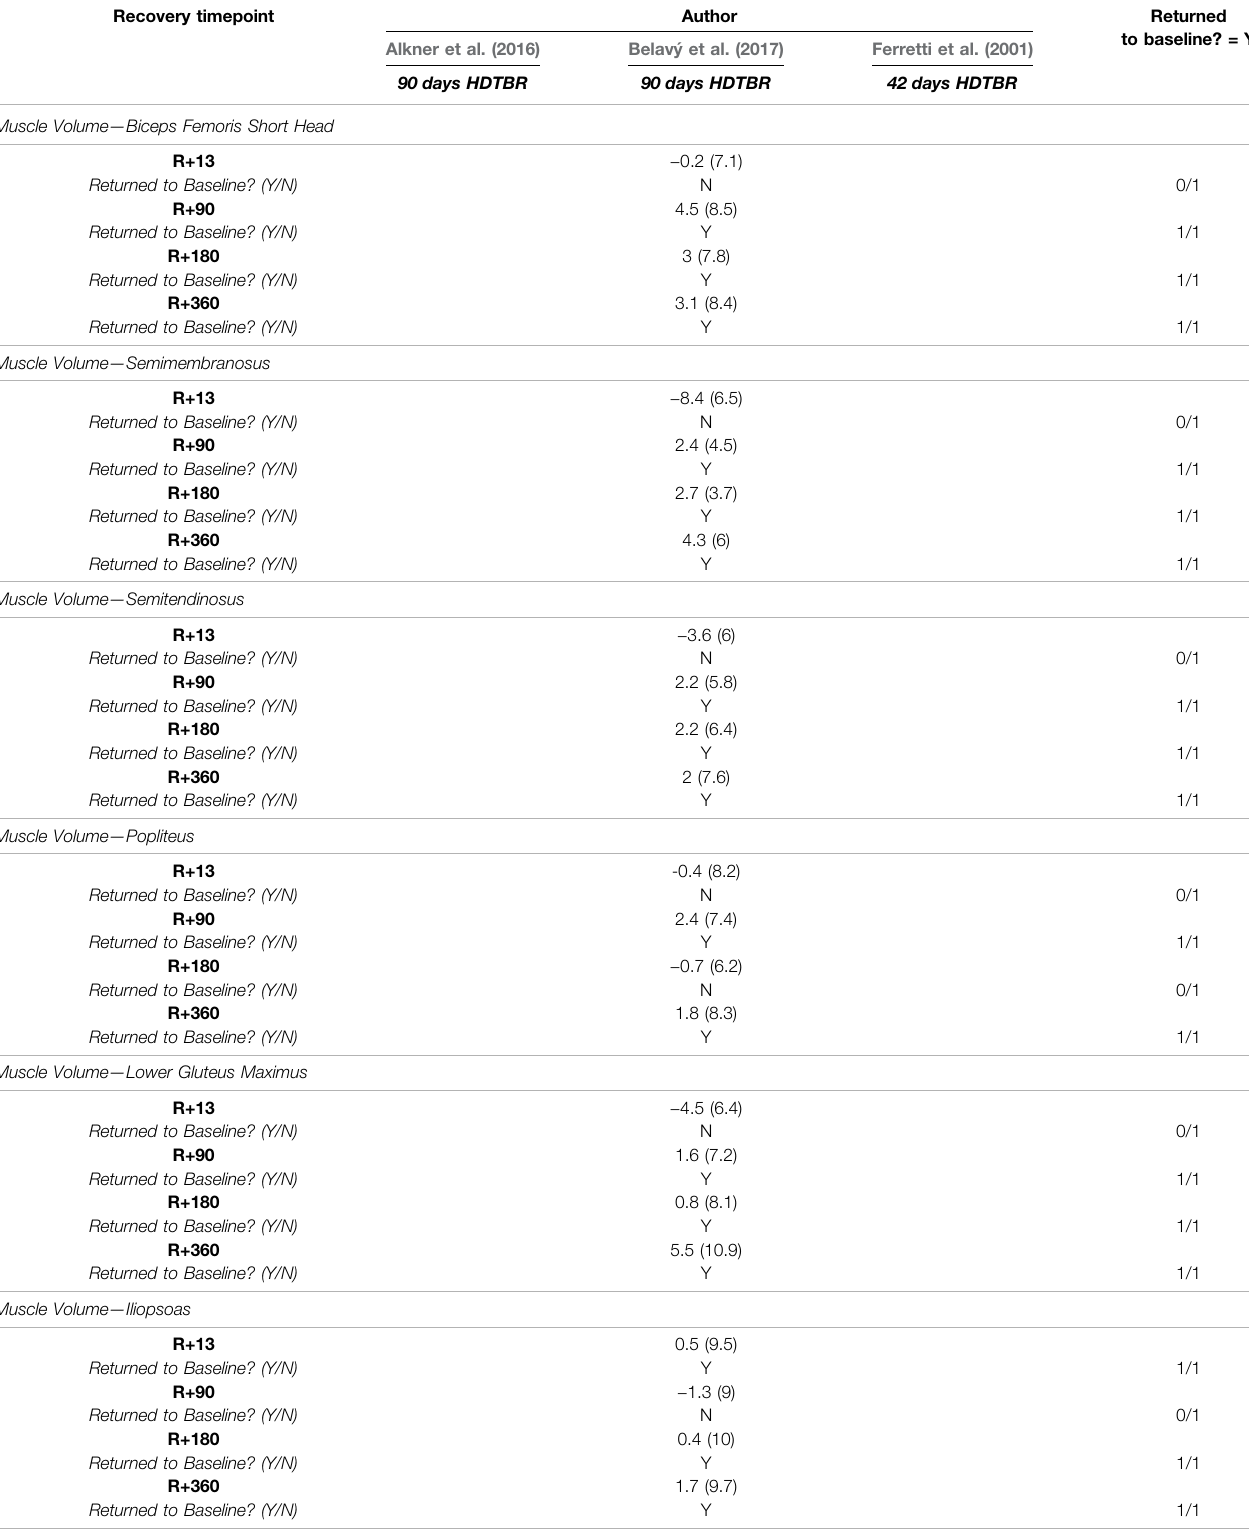
TABLE 5 | ( Continued ) % Change with SD of outcome parameters related to the ‘ Muscular System ’